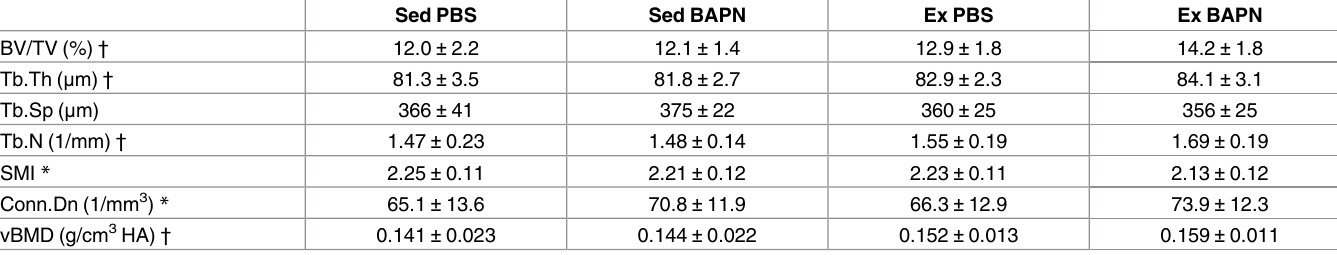
Table 6. Trabecular analysis of proximal